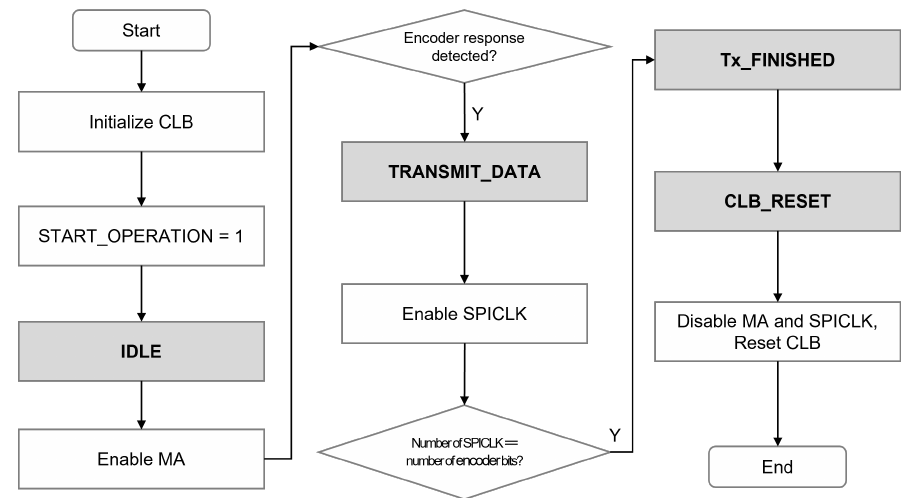
Figure 15. Flowchart of a cycle of receiving a SLO frame.